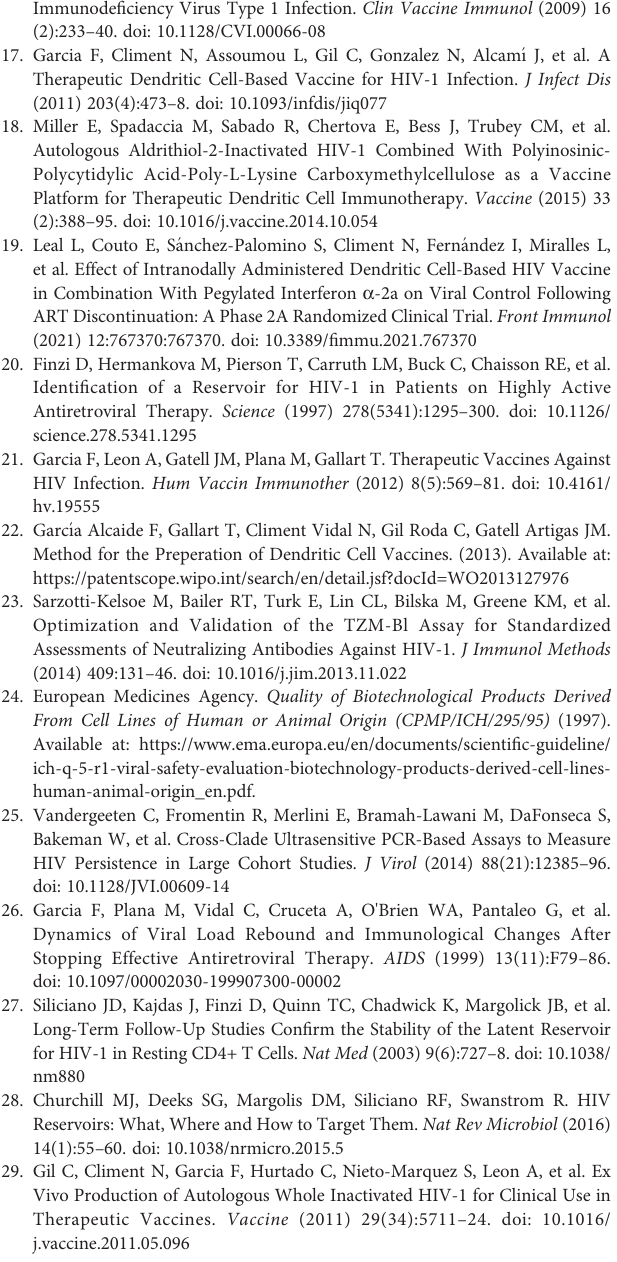
Supplementary Table 2 | Additional data on ART patients subjected to HIV-1 isolation. Patient.1 indicates when the isolation procedure was once more assayed. IQR (interquartile) percentiles as well as 25% and 75% percentiles are speci fi ed at thelowerthreepositionsineachcolumn.ART,AntiretroviralTherapy;VL,ViralLoad; NA, Not Applicable. *, second 100mL peripheral blood extraction. Supplementary Table 3 | Additional viral p24 antigen data on ART patients subjected to HIV-1 isolation. Viral p24 antigen data on patient #9 was not determined. Patient.1 indicates when the isolation procedure was once more assayed. IQR (interquartile) percentiles as well as 25% and 75% percentiles are speci fi ed at the lower three positions in each column. ART, Antiretroviral Therapy; NA, Not Applicable. *, second 100mL peripheral blood